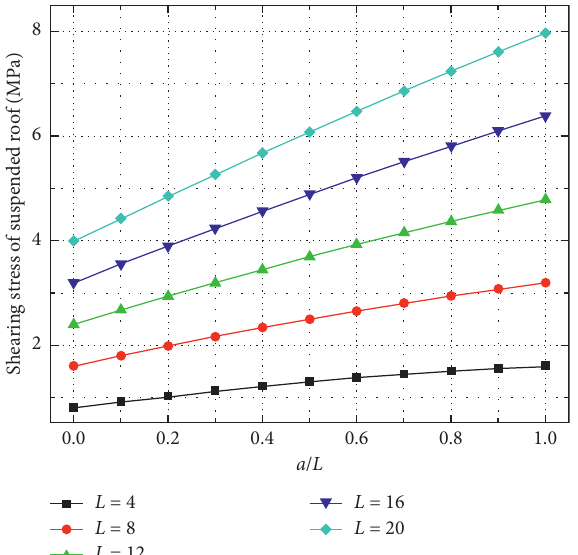
Figure 8: Shearing stress of the suspended roof with “ a / L ”.